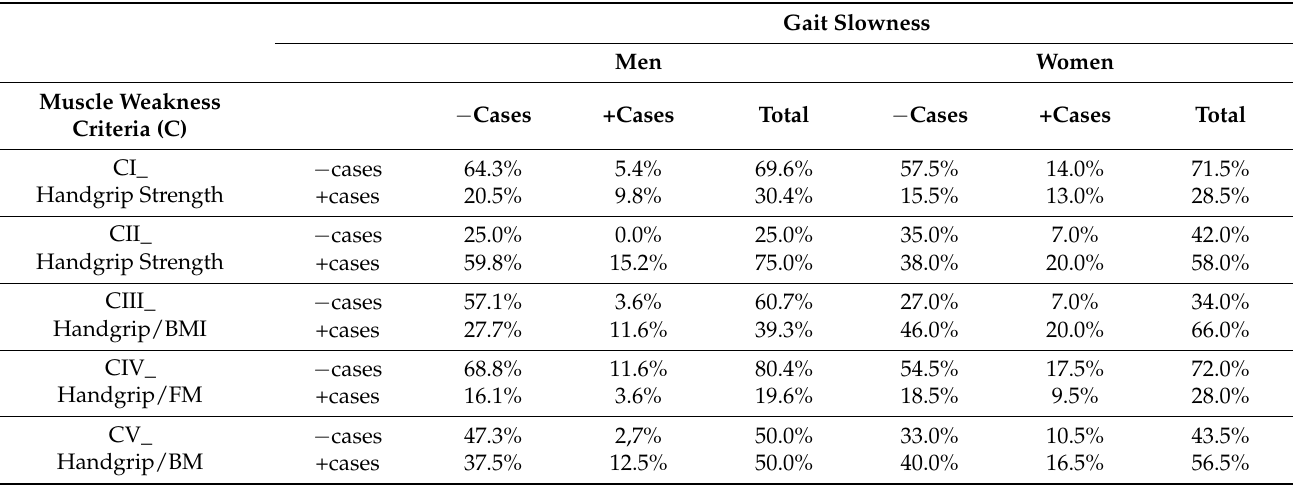
Table 4. Cross classification analysis between positive (+) cases for muscle weakness and for walking slowness by